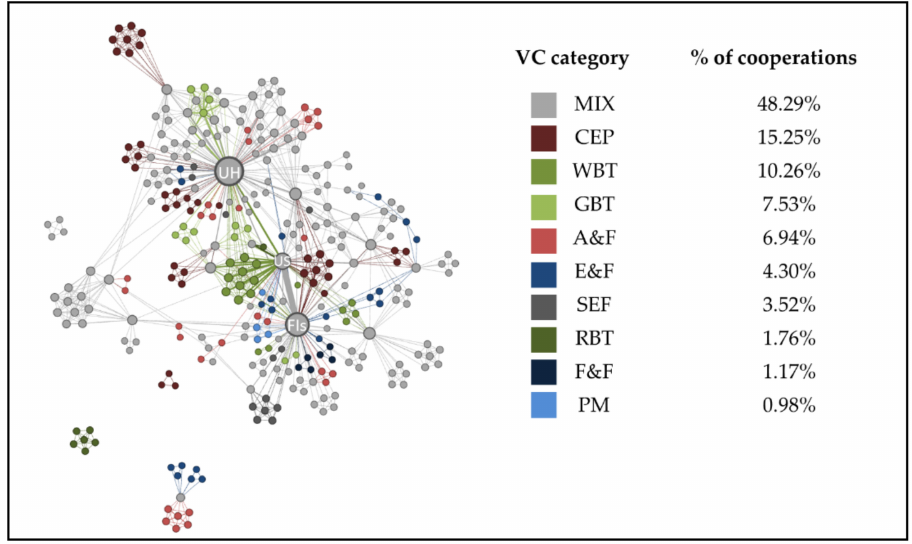
Figure 10. Distribution of bioeconomic topics in the supra-regional network based on the thematic focus of the research